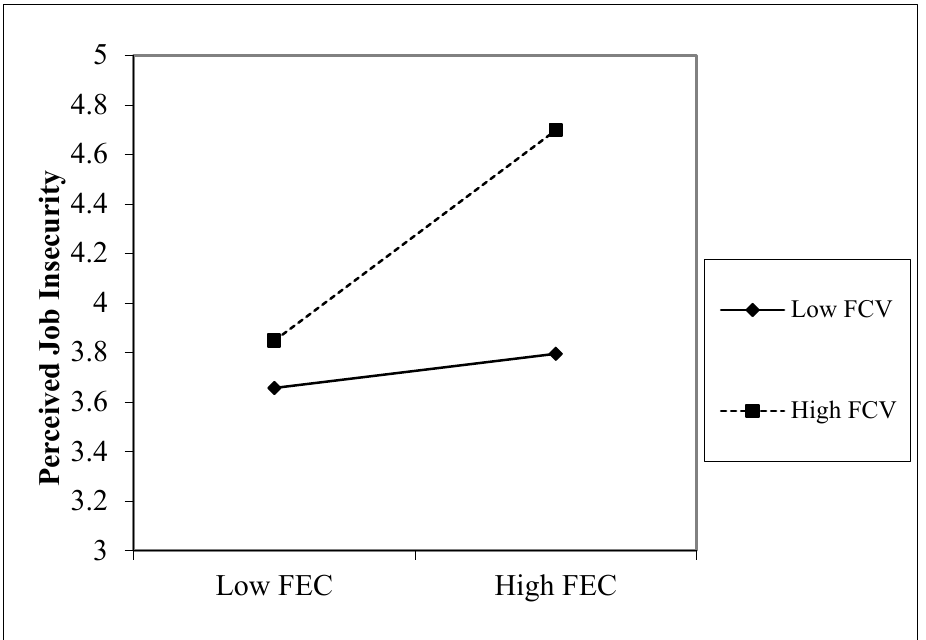
Figure 2. Moderation of FCV ‐ 19 between fear of economic crisis and perceived job insecurity.